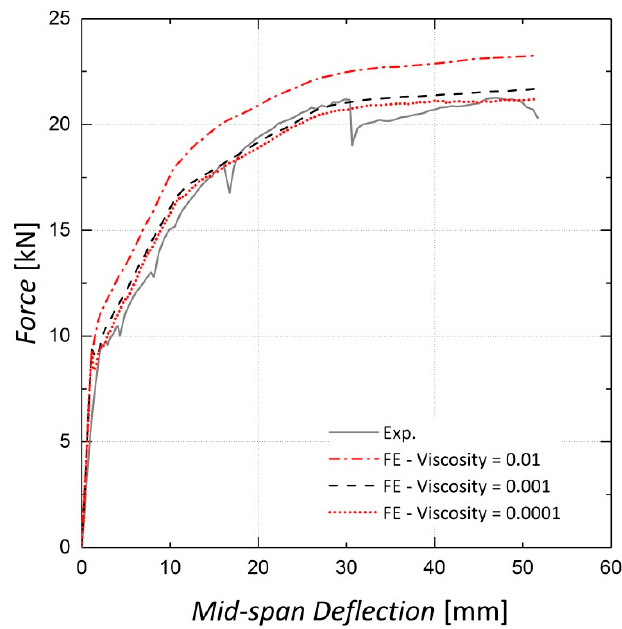
Figure 14. Sensitivity of results to viscosity—Beam 10.